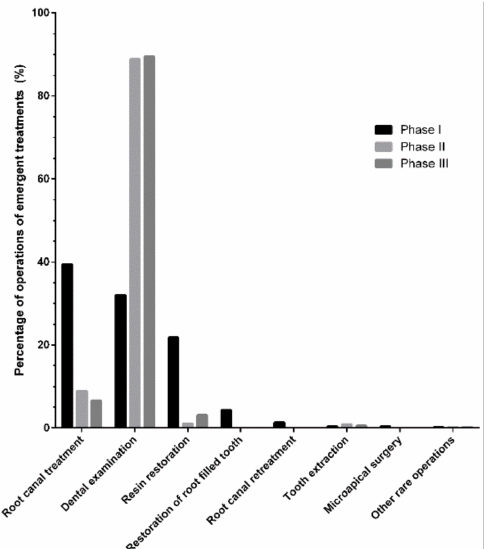
Figure 4. Percentages of emergent dental procedures for ODE-related diseases during three periods (rare procedures included occlusal adjustment, apical barrier technique, and other rare